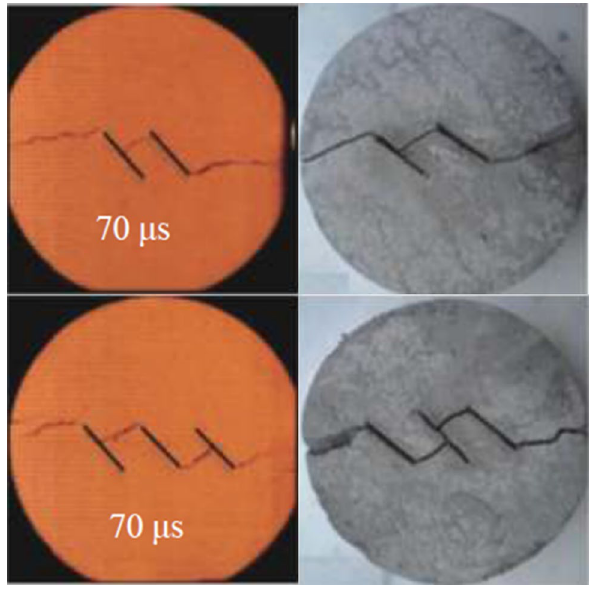
Fig. 8 A comparison between the failure patterns on 3DP samples (left) and the cement samples (right) (Jiang et al.